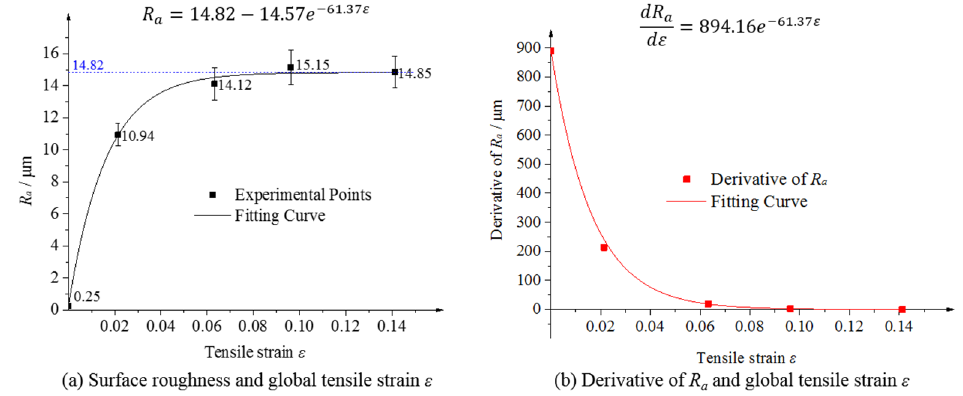
Figure 4. Surface roughness of the sample at different strain